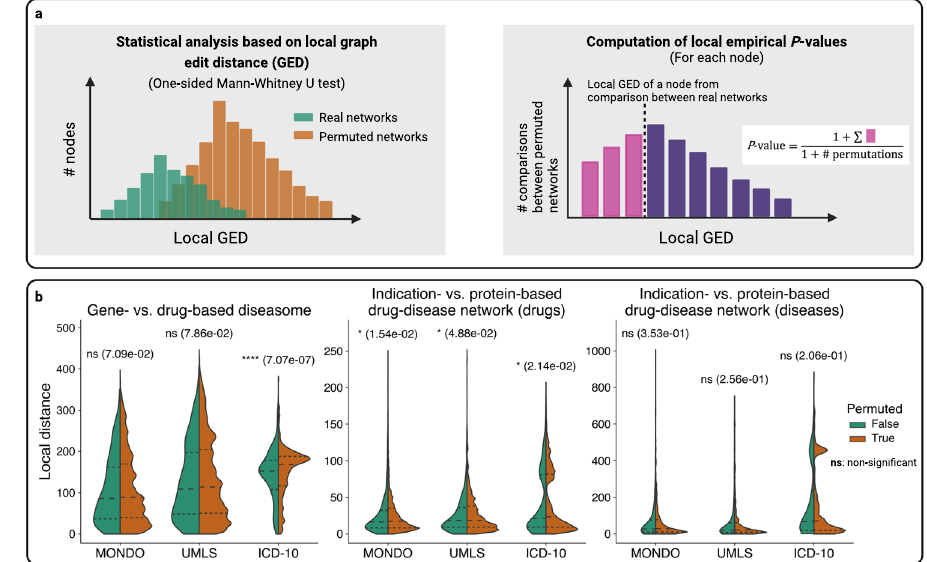
Fig.5|Local-scaleanalyses:methodsandlocalGEDs.a Illustrationoflocal-scale analysismethods.Leftpanel:Statisticalanalyses based on localGEDviaMWU test. Right panel: Computation of empirical P -values (one-sided, unadjusted) of each node based on local GEDs. b Local GEDs (of all nodes) between a selection of original networks vs. their permuted counterpart networks and corresponding Fig. 5b (for the full results of the local-scale analyses, see Supplemen- tary Fig. 7). The overview of the results of the local GED analyses in different vocabularies shows that the comparisons performed in ICD- 10 vocabulary (at three-character level) led to more signi fi cant simi- larities than the ones performed in MONDO or UMLS CUI vocabulary